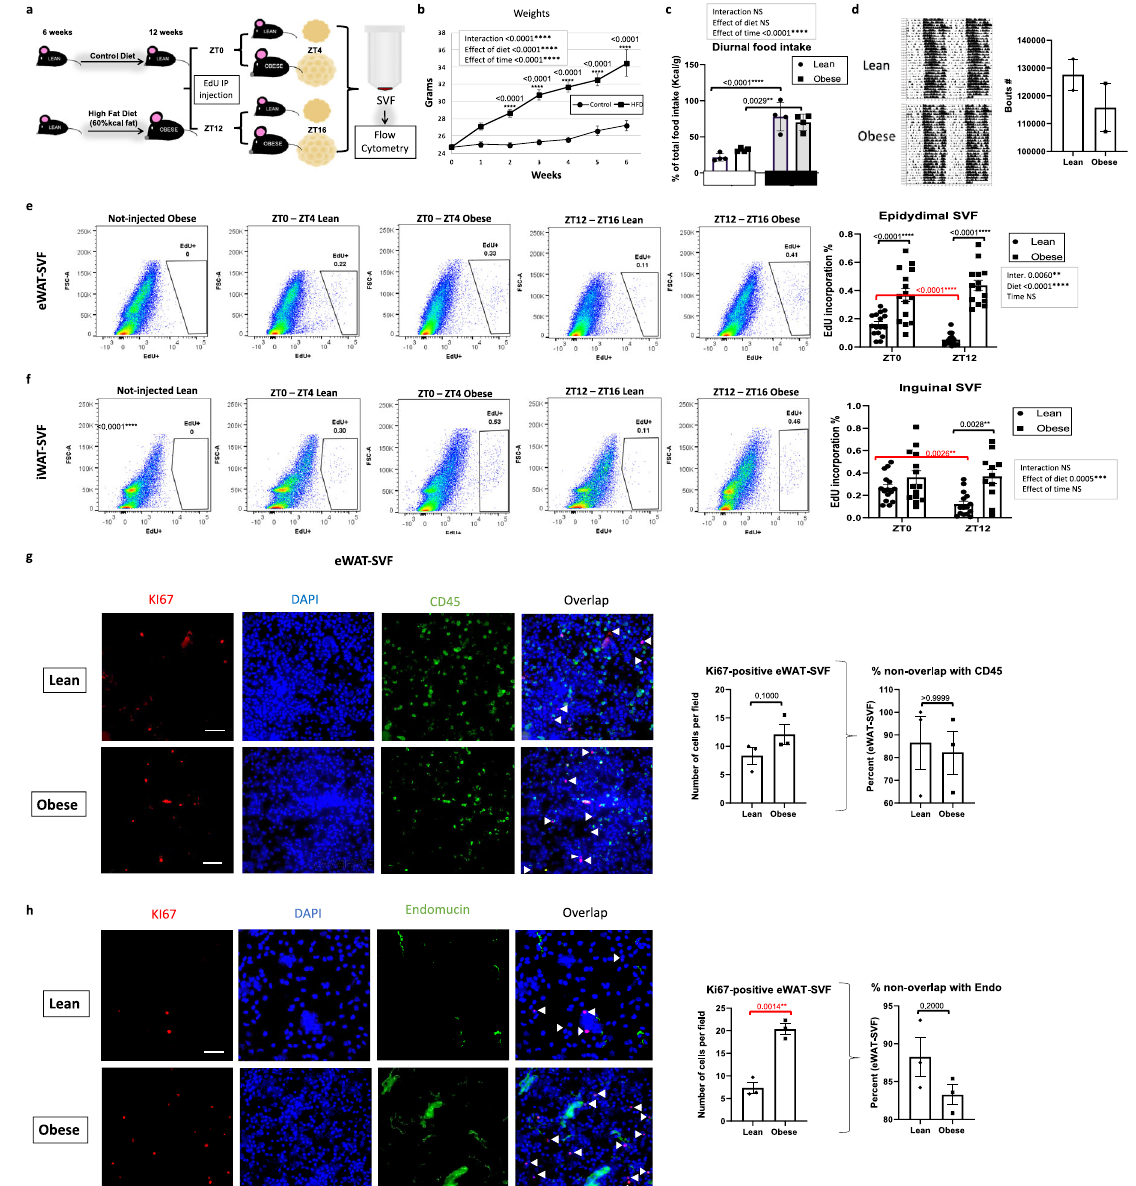
Fig. 3 High-fat feeding disrupts the diurnal pattern of adipose stromal vascular cell proliferation in vivo. a Model of diet-induced obesity: 5-ethynyl-2 ʹ - deoxyuridine (EdU) was intraperitoneally (IP) injected at zeitgeber time (ZT) 0 or ZT12 to lean mice fed control or high-fat diet (HFD) ad libitum. Epididymal fat (eWAT) and inguinal fat (iWAT)-derived stromal vascular cell fractions (SVF) were isolated from fat pads collected 4 h following EdU injection. b Weekly weight gain in chow and HFD-fed mice ( n = 16 animals per diet). c Percent change in total food intake (kcal/g mouse) in light (white bar) vs. dark (gray bar) of mice fed vivarium chow or HFD ad libitum ( n = 4 animals/diet and light or dark period). d Diurnal locomotion of group-housed mice as measured by infrared sensors (left panel) and corresponding quanti fi cation of bouts of activity (right panel). n = 2 cages with group-housed mice per each diet. e , f Representative fl uorescence activated cell sorting of EdU-positive cells in eWAT ( e ) and iWAT ( f ) SVF (left panels) isolated at ZT4 and ZT16, 4 h following a single EdU injection, and respective quanti fi cation (right panels) ( n = 16 animals/diet and ZT). g , h Representative staining of KI67 (vs. CD45)-positive cells ( g ) or KI67 (vs. endomucin)-positive cells ( h ) in eWAT-SVF (left panels) (scale bar = 50 µ m) and respective quanti fi cation (right panels) ( n = 3 animals/diet). t White arrows indicate the non-overlapping KI67. For all bar graphs, circles and squares represent lean and obese mice, respectively. Data are represented as mean ± SEM. * p < 0.05, ** p < 0.01, *** p < 0.001, **** p < 0.0001. Signi fi cance ( p < 0.05) determined by two-way ANOVA and Sidak ’ s post hoc test in ( b ) [F time(19, 2289) = 237.1 / F diet(1, 2289) = 1337] or Tukey ’ s post hoc test in ( c ) [F time(1, 12) = 65.12 / F diet(1, 12) = 0.04475], ( e ) [F time(1, 56) = 0.4699 / F diet(1, 56) = 90.16], and ( f ) [F time(1, 51) = 2.271 / F diet(1, 51) = 13.86]; and two-tailed Mann – Whitney U test in ( g , h ). Red asterisks reveal signi fi cance determined by two-tailed unpaired t